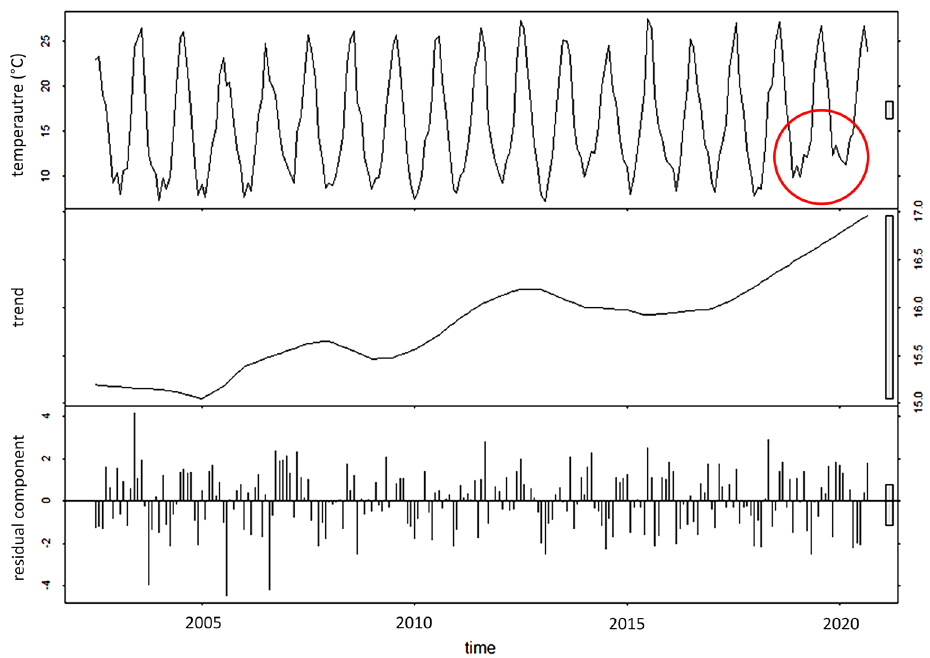
Figure 6. MODIS Aqua sea surface temperature at Tremiti archipelago (Adriatic Sea), between 2002 and 2020, with indication of the trend and the residual component. The red circle shows high surface temperatures during winter 2019 and 2020.